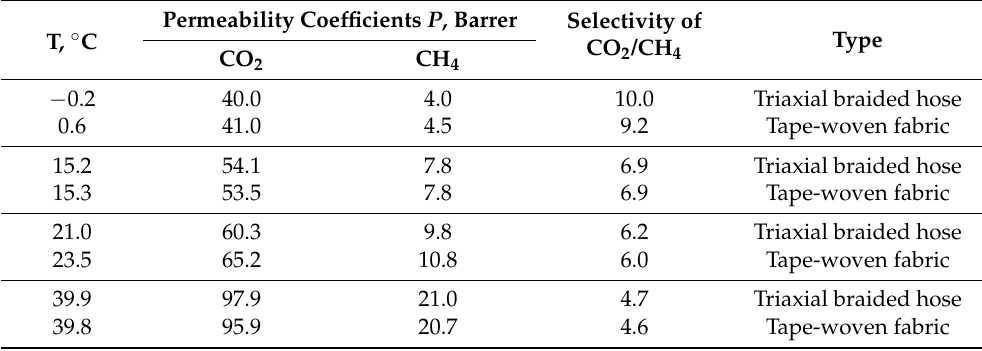
Table 3. Permeability coefficients of 3D structured HFs for CO 2 /CH 4 mixture in the temperature range of 0 to 40 ◦ C.